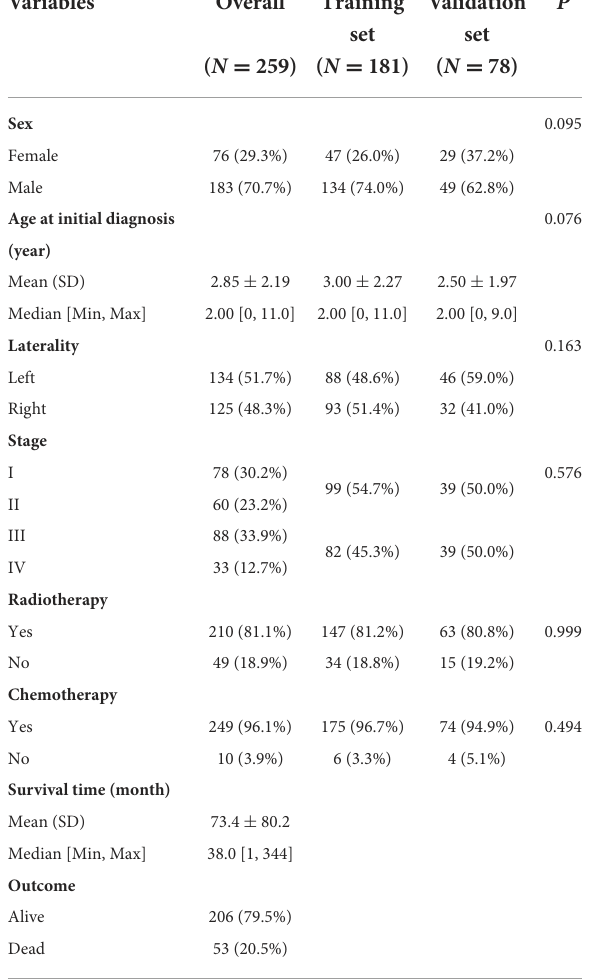
TABLE 2 Clinical characteristics in the OS group and the Chi-square test between TS and VS.